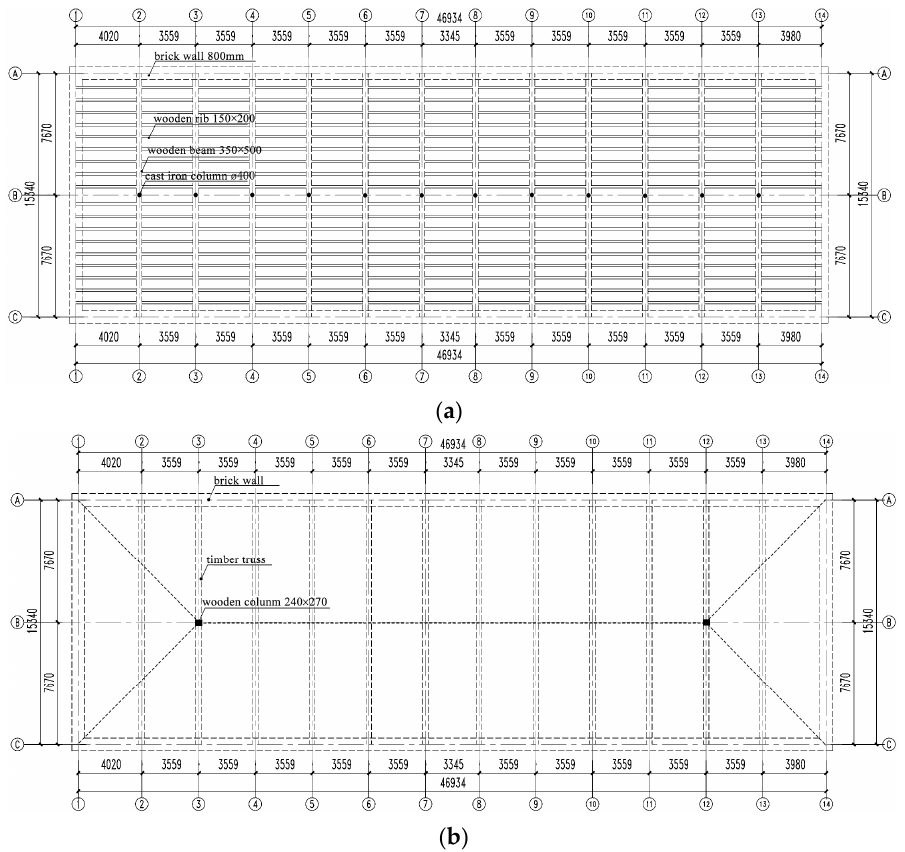
Figure 13. ( a ) Structural diagram of the first floor. Picture by X.X. ( b ) Structural diagram of the second floor. Picture by X.X. Table 2. ( a ) Structural check: calculation of load‑bearing wall (seismic check). ( b ) Structural check: calculated value of load-bearing wall (compression bearing capacity check).